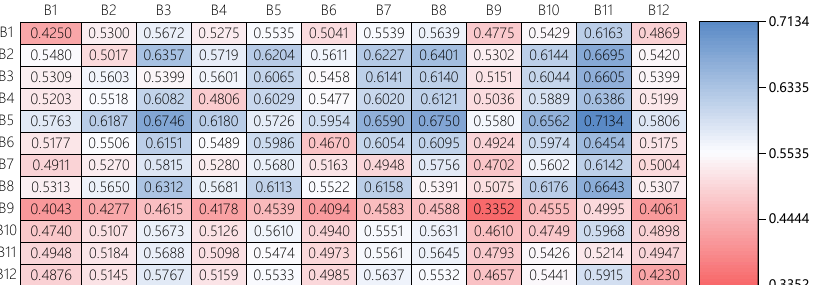
Figure 4. Heatmap of the total relation matrix.